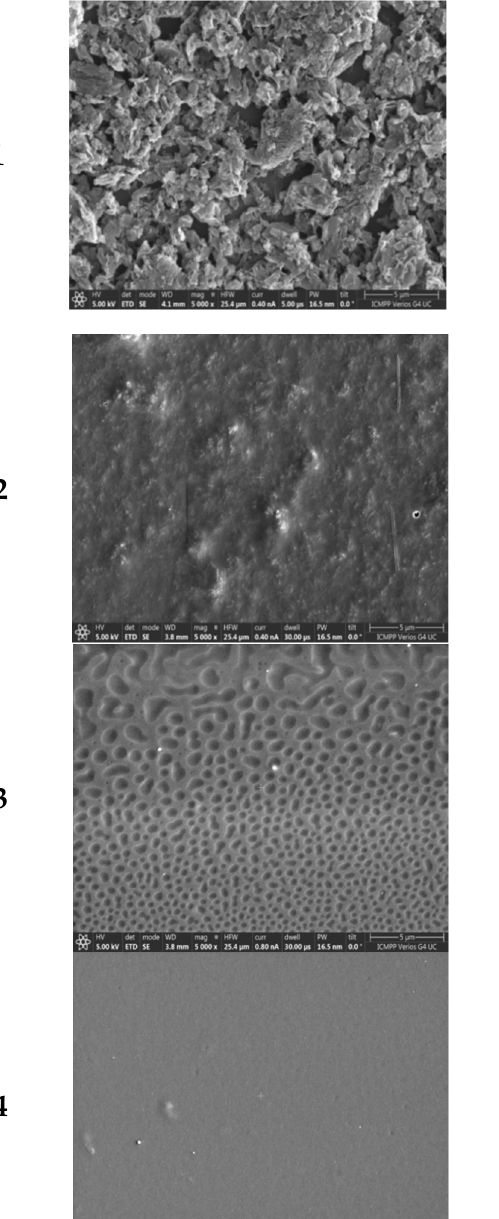
7 of 18 Figure 1. FT-IR spectra of polymers P1 – P4 containing naphthyl(di)imide units. 3.2. Films Morphology Generally, polymers can lead to defectless thin films, with flat and homogeneous surfaces, suitable for use as active layers in various applications, particularly in optoelec- tronics. This prerequisite is necessary to allow the current to flow through the device